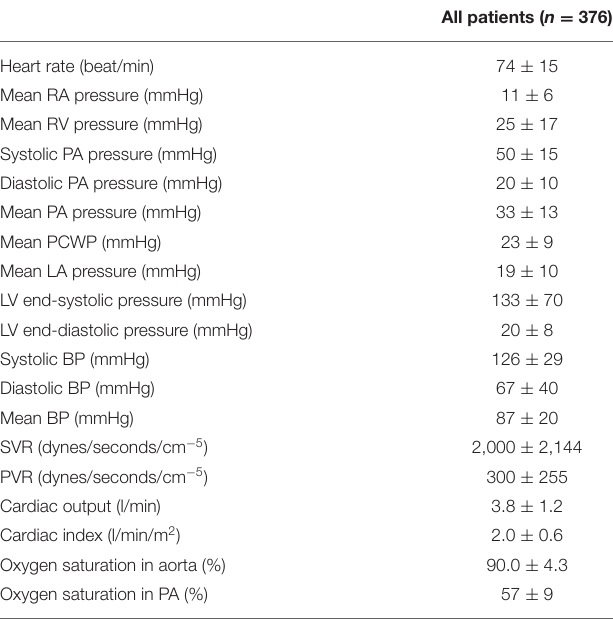
TABLE 2 | Hemodynamic measurements in study population.